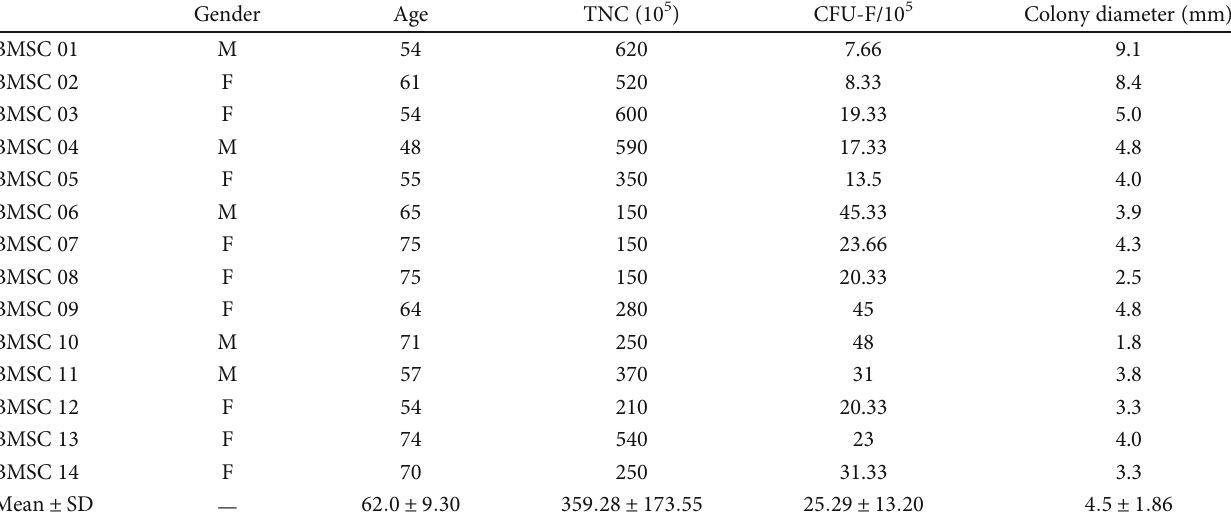
Table 1: Characteristics of donor patients and colony-forming e ffi ciency (CFE)